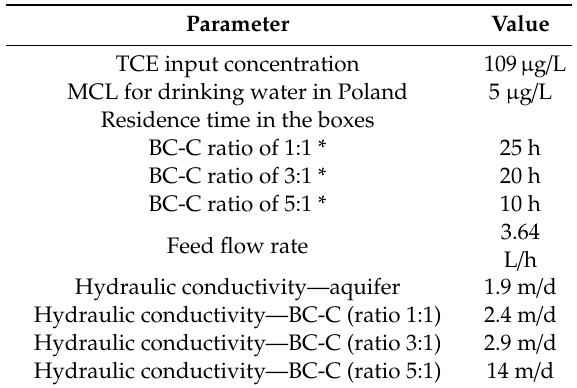
Table 2. Design parameters for the pilot field